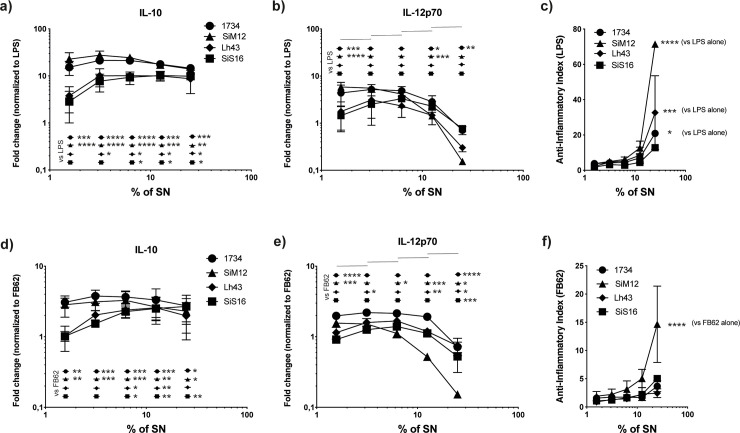
Production of IL-10 and IL-12p70 cytokines in co-culture experiments between moDCs and LPS and Salmonella strain in presence of postbiotics.The production of IL-10 and IL-12p70 cytokines, in co-culture experiments between moDCs and lipopolysaccharides (LPS) (a, b) or Salmonella FB62 (d, e) in presence of postbiotics (expressed as % added supernatants, % SN -25%, 12,5%,6,25%, 3,12%, 1,56% -) of Lactobacillus helveticus SIM12, Lh43, SIS16, and 1734, were displayed. The anti-inflammatory index (IL-10/IL-12p70) is reported for each strain (c, f). Statistical significance of single bacteria strain was evaluated by using two-way ANOVA followed by multiple comparisons (Tukey) against the control and the serial dilution values (b, e). Values represent the means ± SD, 95% CI, (*P<0.05, **P<0.01, ***P<0.001, ****P<0.0001).